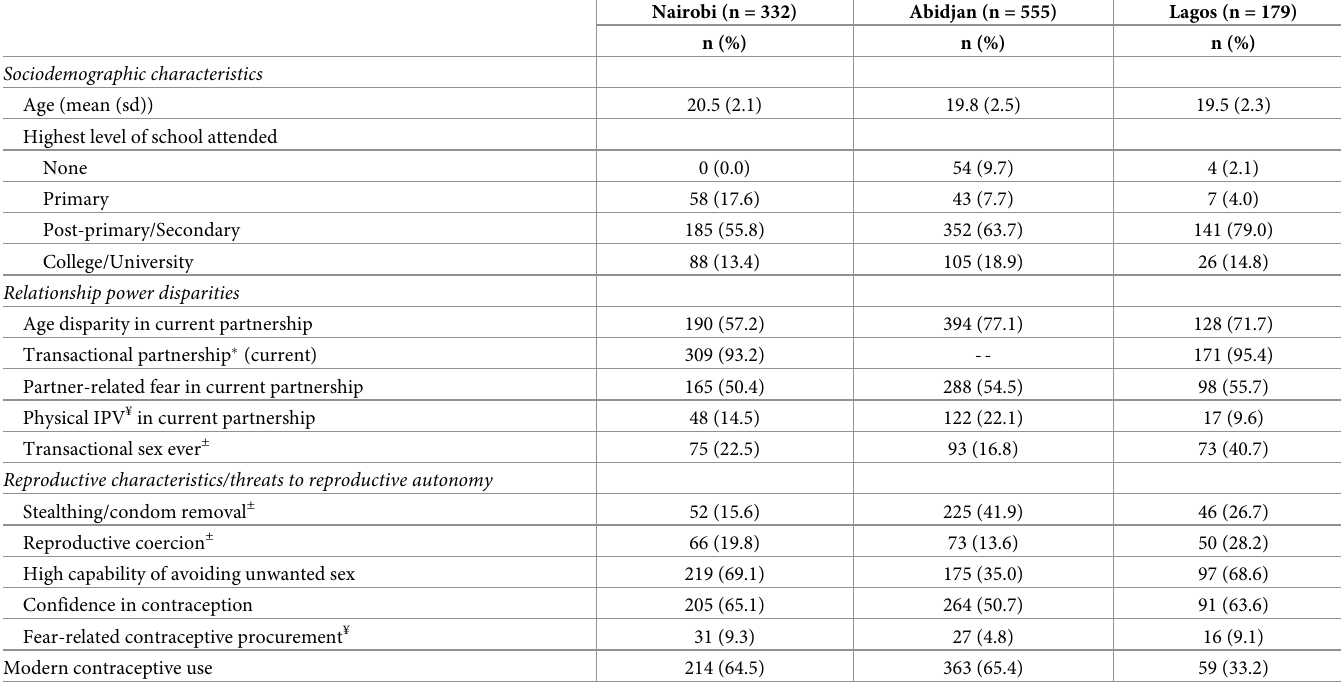
Table 1. Sample characteristics, relationship power disparities, and sexual/reproductive health profile of unmarried, currently-partnered AGYW by site, weighted (n = 1,066).